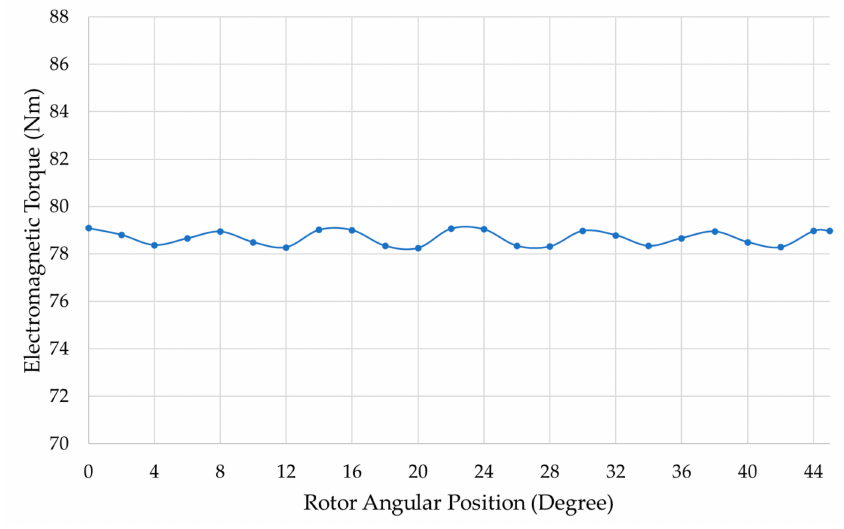
Figure 7. The torque behavior at base speed (28 A).